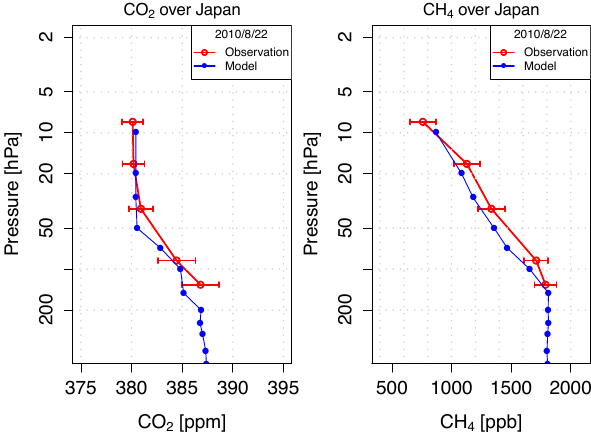
Fig. 8. Vertical profiles of CO 2 (left) and CH 4 (right) in the strato- sphere over Japan. The blue lines indicate NIES TM simulated data on 22 August 2010. The red lines are observed average profiles and their standard deviations derived from balloon-borne measurements over Sanriku, Japan (39.2 ◦ N, 141.8 ◦